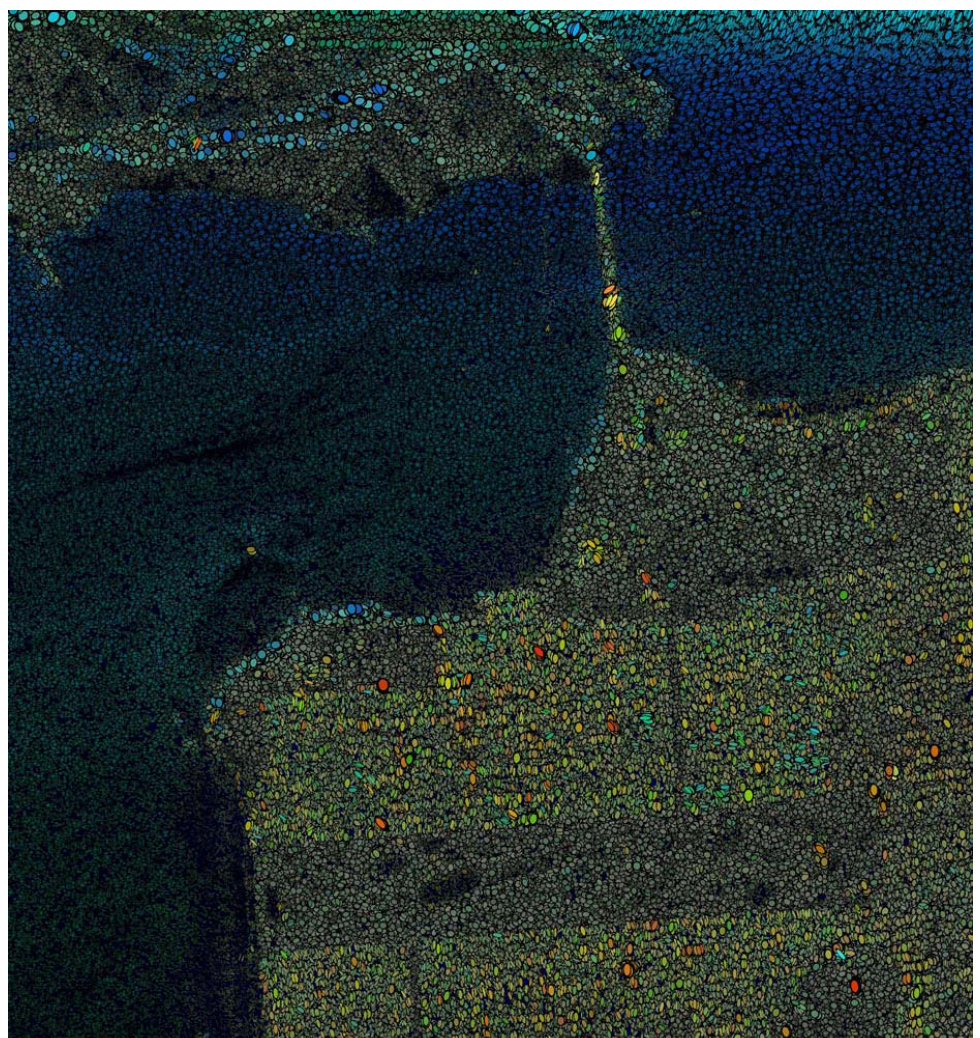
Figure 2. Visualization of L-band data over the North West part of San Francisco (near range is at the top of the image). The Golden Gate Bridge is clearly seen to the North of the city. The unsaturated rectangular area near the bottom of the image is Golden Gate